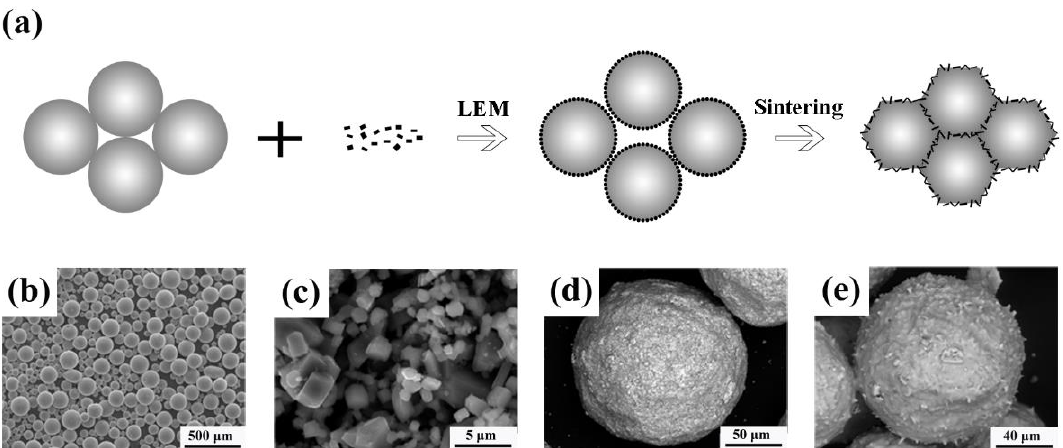
Figure 1. The process flowchart ( a ), SEM of spherical Ti-6Al-4V-powders ( b ), SEM of prismatic TiB 2 powders ( c ), SEM of mixed powders ( d ), SEM of as-sintered composites ( e ).